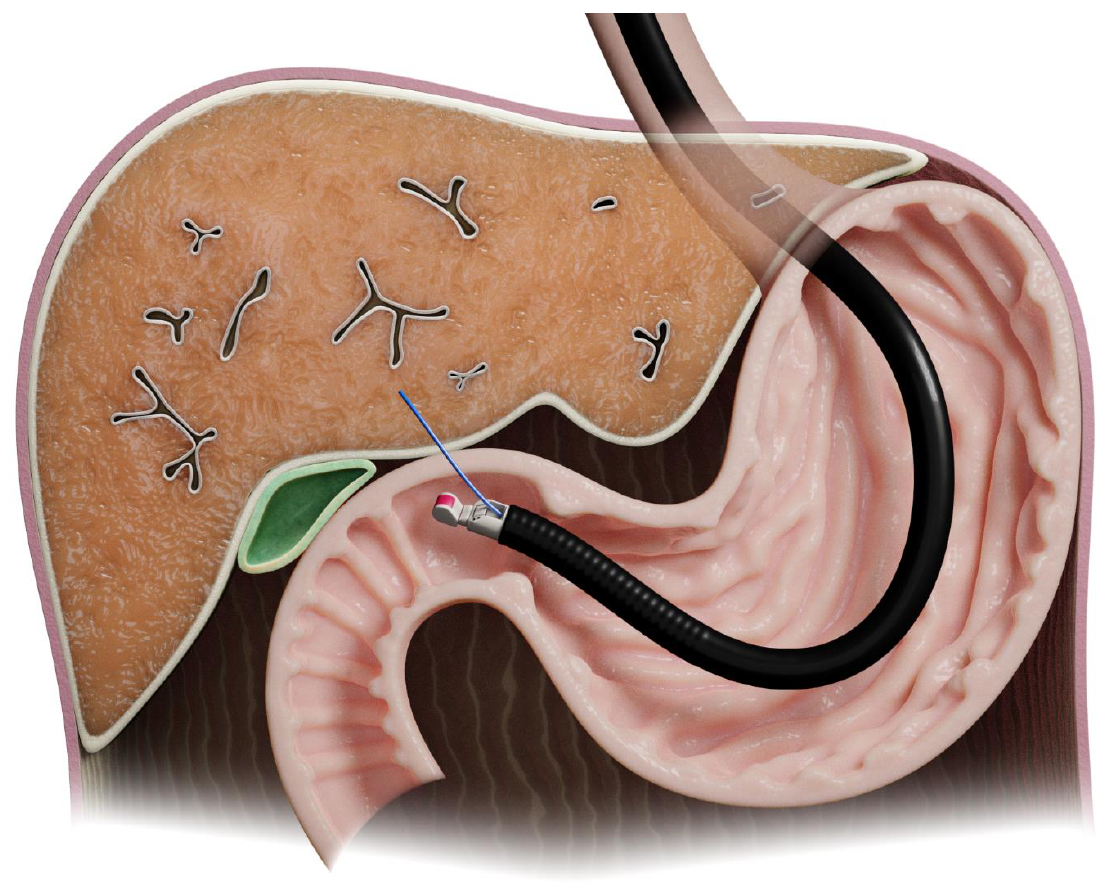
Figure 3. Illustration of endoscopic-ultrasound-guided liver